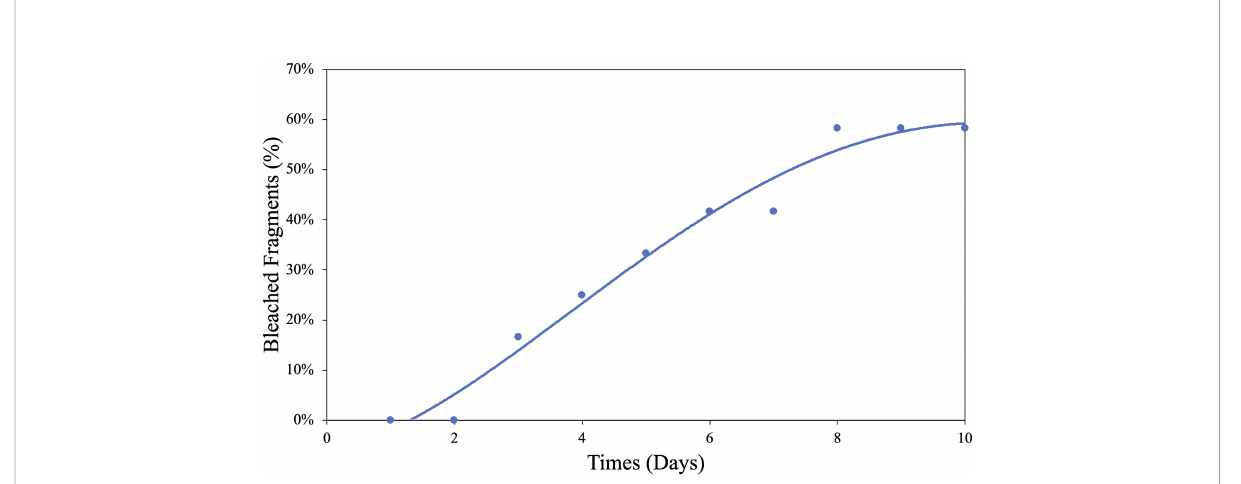
FIGURE 2 Hypoxic bleaching threshold determination for G. fascicularis . The median sublethal bleaching time for G. fascicularis , the SLT 50 , was estimated at 5.15 ± 0.80SE days at 32°C.